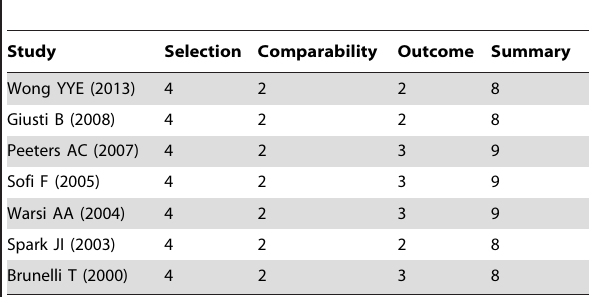
Table 2. The Newcastle-Ottawa Quality Assessment Scale for case–control studies.